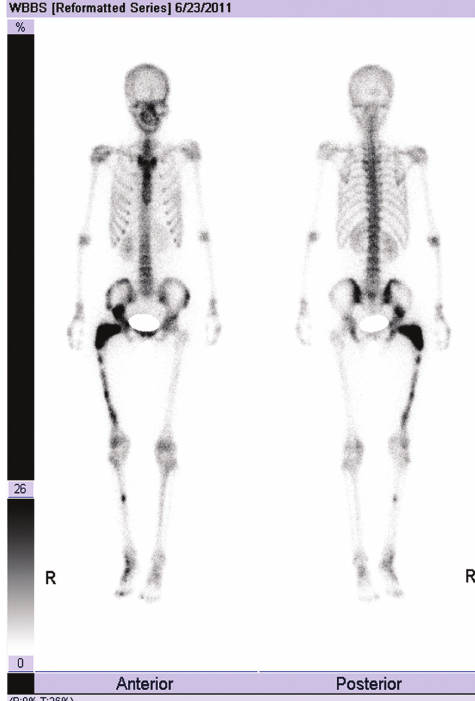
Figure 7: Tc-99m MDP WBBS found abnormal intensive accumulation in right femur, tibia, and cotyle suggesting tumor, and decreased accumulation in upper right femur due to the previous